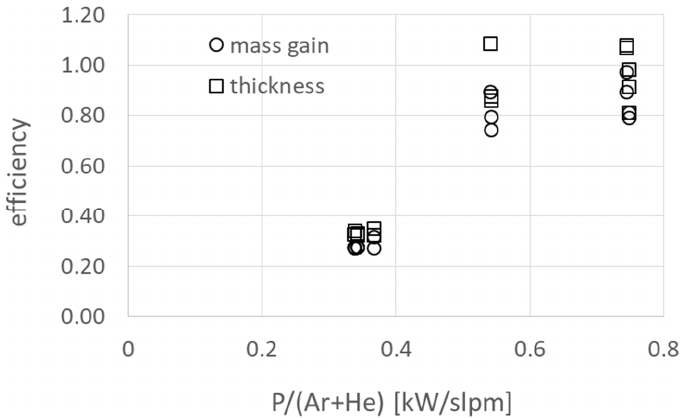
Figure 4. Efficiency of the different spray trials as a function of the power normalised to the total gas flow (circles: efficiency from mass gain, squares: from coating thickness) for different substrates.